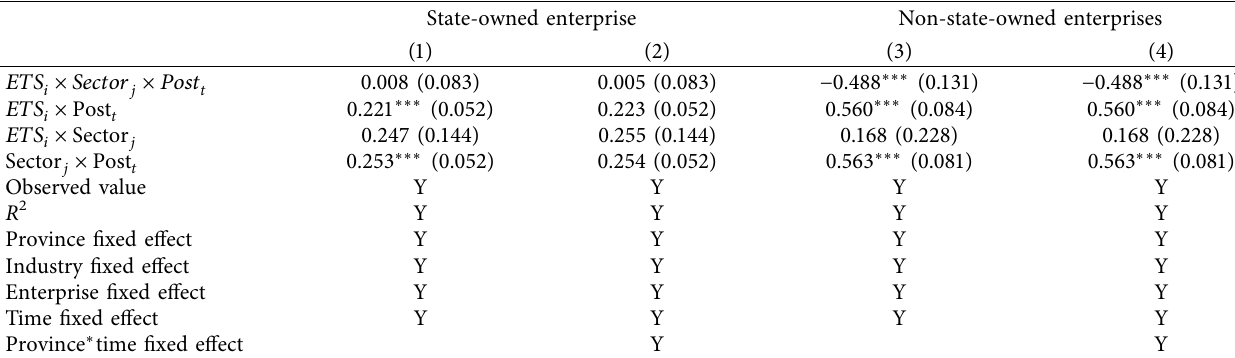
Table 4: Heterogeneity analysis of considering enterprise ownership attribute.